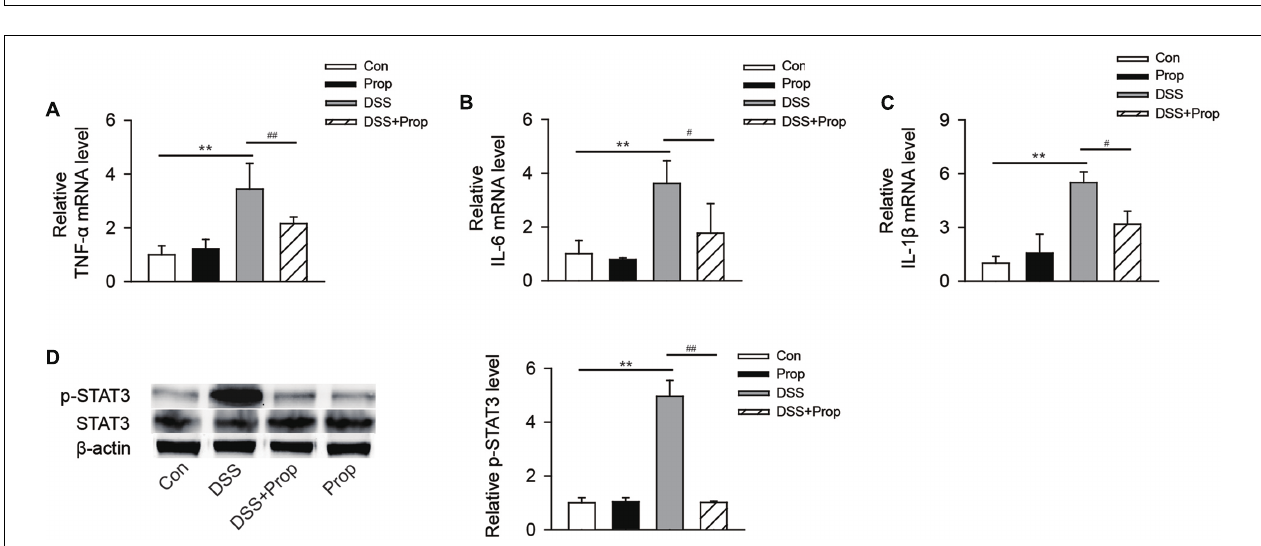
FIGURE 2 | The effects of sodium propionate on intestinal barrier function in DSS-induced mice. The FITC-dextran levels in serum were determined (A) . n = 10 per group. The expression of tight junction and associated protein ZO-1, E-cadherin and occluding in colonic tissues was determined by immunoblotting (B–E) . β -actin was used as the protein loading control. n = 4 per group. Representative blots of three independent experiments are shown. Data are presented as mean ± SD. ∗ P < 0.05, ∗∗ P < 0.01 vs. control group; # P < 0.05, ## P < 0.01 vs. DSS group.